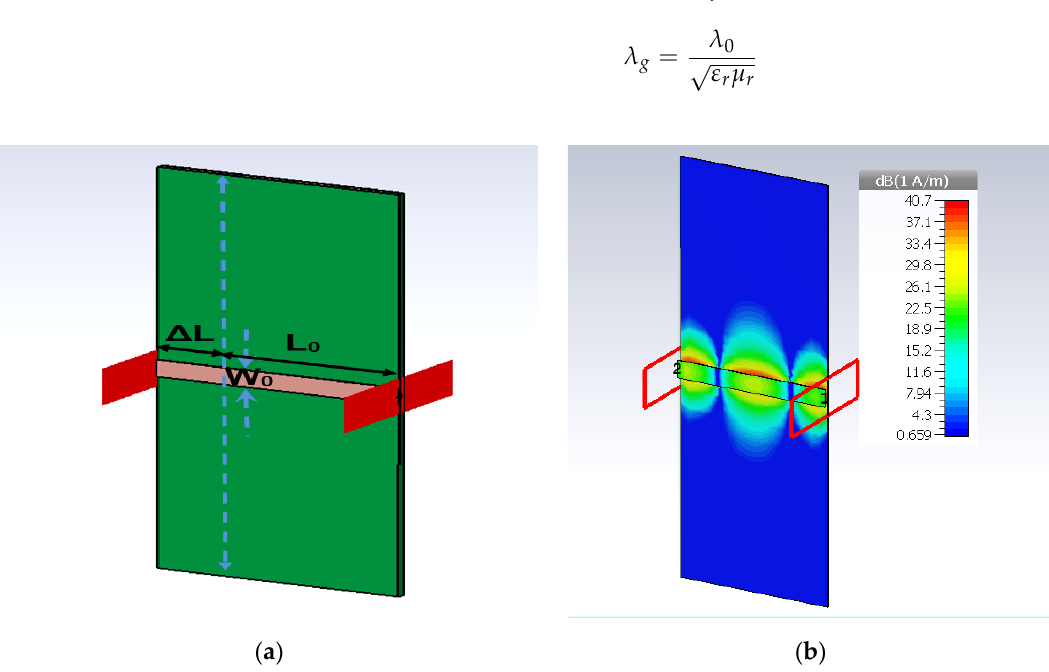
Figure 5. Configuration of ( a ) strip line and ( b ) current distributions.